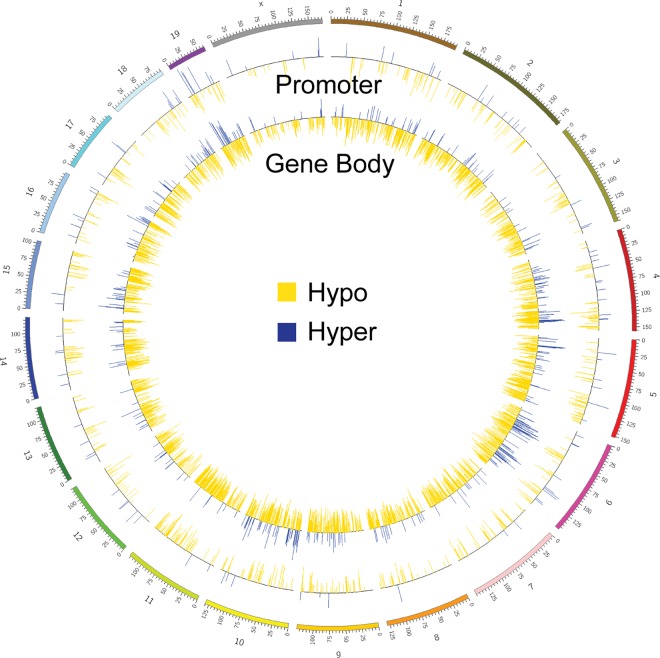
Promoter and gene-body hypomethylation is present throughout the genome of Dnmt3aΔ/Δ PTCLs.Circos plot of DMRS annotated to promoters and gene bodies in Dnmt3aΔ/Δ PTCL relative to wild-type CD8+ cells. DMRs aligning to promoter (outer circle) and gene body (inner circles) are displayed in relation to its chromosomal position in the mouse genome. Hypomethylated DMRS are indicated by yellow lines and hypermethylated DMRS are indicated by blue lines.